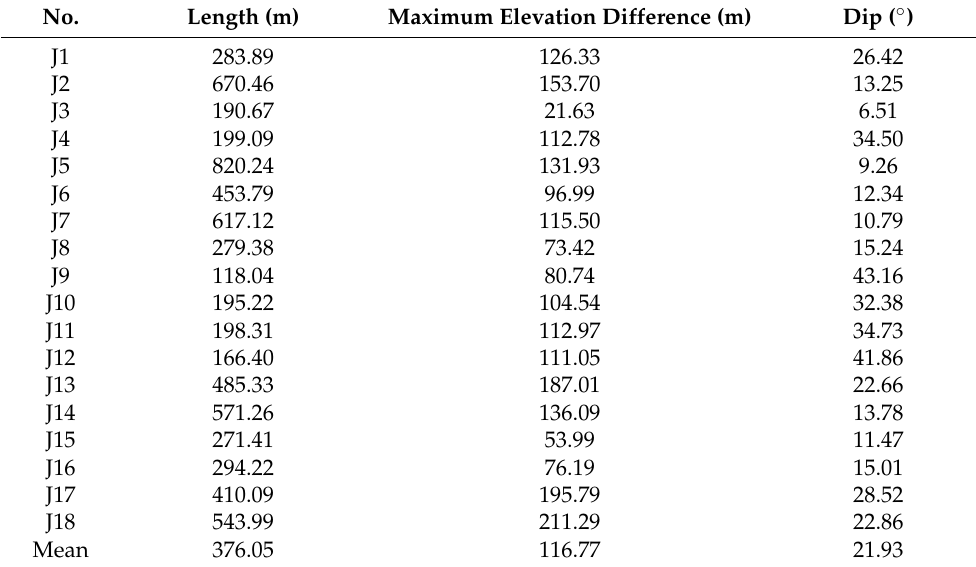
Table 5. Measurement results of ridge lines’ morphological parameters.